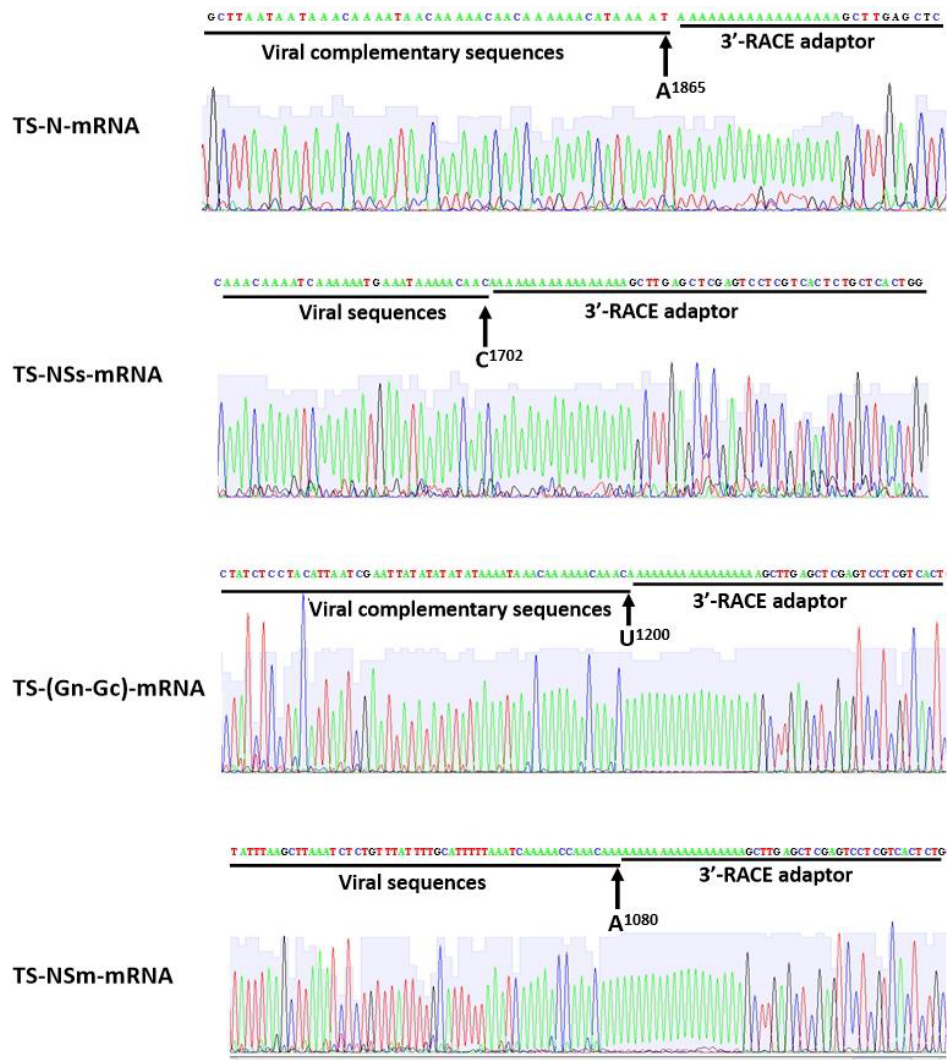
Figure 1. Precise mapping of TSWV sgRNA 3′ terminal region nucleotide sequences by 3′RACE. Note: The locations marked by numbers represent viral strands.